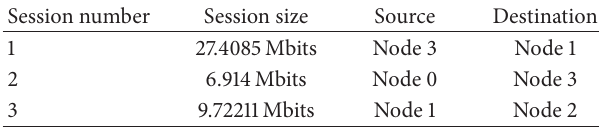
not considered) and parameter settings in [11] as follows: 𝑃 𝑜 = Table 1: The size, source, and destination nodes of three